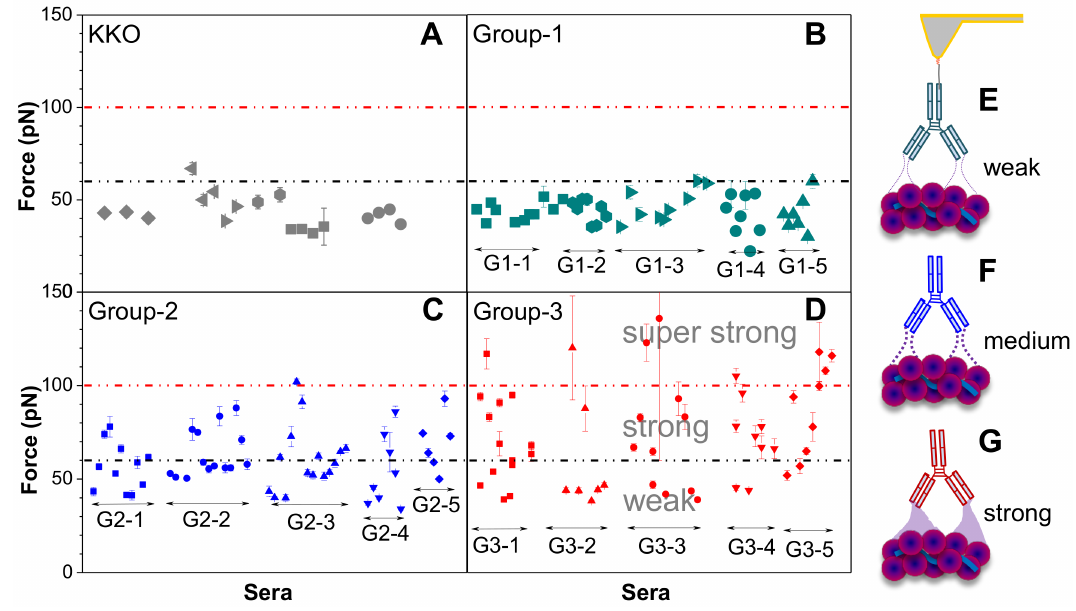
Figure 3. Binding strength of aPF4/H Abs to PF4/H complexes. Each dot shows the mean and standard error of the rupture force for each respective antibody from five sera per group. ( A ) KKO and ( B ) group-1 Abs bind to PF4/H complexes with a binding strength mostly ≤ 60 pN (black dotted line), while ( C ) group-2 and ( D ) group-3 Abs consist of Abs with different binding forces. Cartoons show weak ( E ), medium ( F ) and strong ( G ) interaction force of KKO/group-1, group-2 and group-3, respectively, when interacting with PF4/H complexes. Adapted from